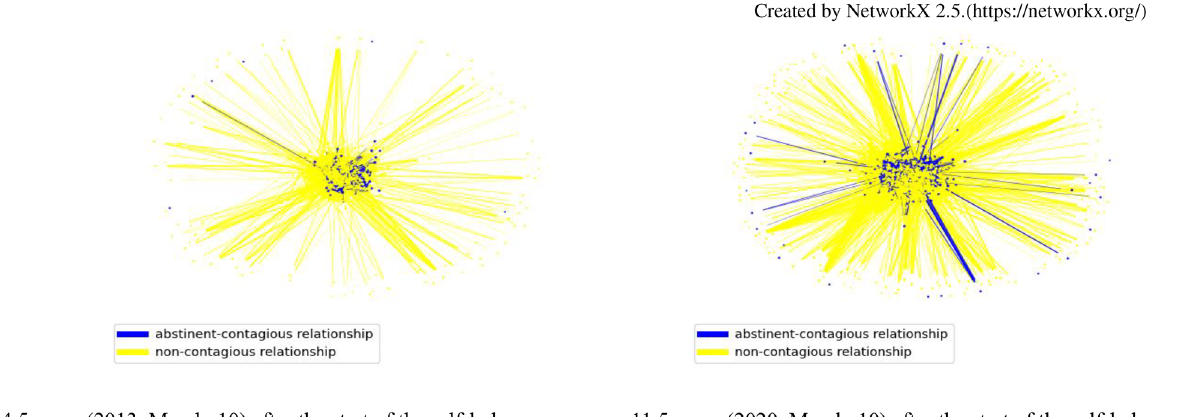
Figure 4. Social contagion of gambling abstinence via abstinent gamblers in the online self-help group. Blue nodes indicate abstinent gamblers who have been abstinent for at least three years, whereas yellow nodes indicate non-abstinent gamblers. The blue edges show the abstinent-contagious relationship of a gambler who became abstinent before talking to another gambler who later became abstinent. The yellow edges indicate noncontagious relationships. The number of abstinent gamblers who received comments from other gamblers 4.5 years later and 11.5 years later were 53 and 161, respectively. The number of non-abstinent gamblers who received comments from other gamblers 4.5 years later and 11.5 years later were 454 and 928, respectively. The time periods to receive comments were limited to the first three years of participation in the forums in this study.